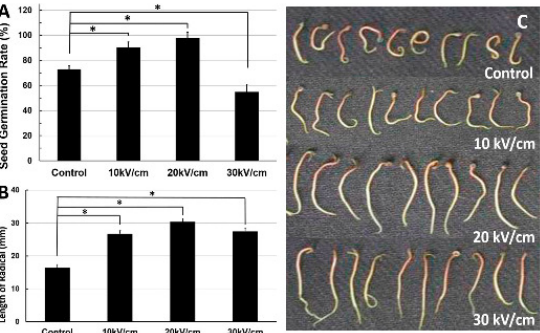
Figure 7. Effects of different intensities of nsPEF on the seed germination rate and radical length of Haloxylon ammodendron . ( A ): Seed germination rate at different electric fields. ( B ): Length of radical at different electric fields. ( C ): Image of radical length at different electric fields. Taken from the journal Plasma Processes and Polymers , article “Early Growth Effects of Nanosecond Pulsed Electric Field (nsPEFs) Exposure on Haloxylon ammodendron ”. Copyright Wiley–VCH GmbH. Reproduced with